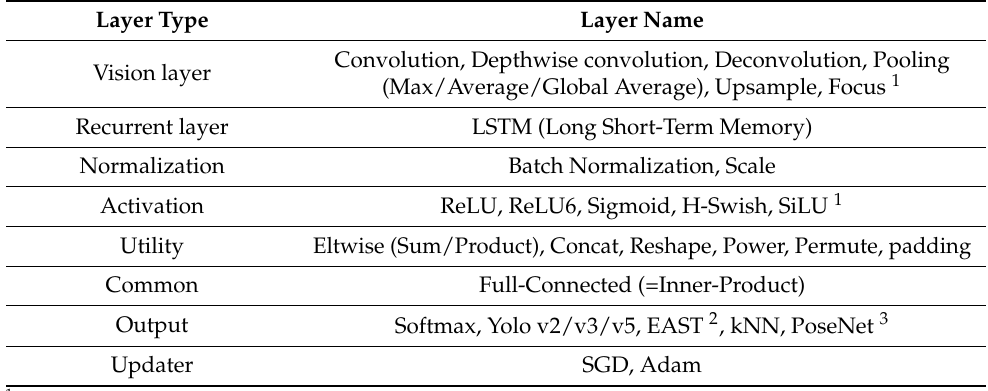
Table 1. List of hidden and output layers of our